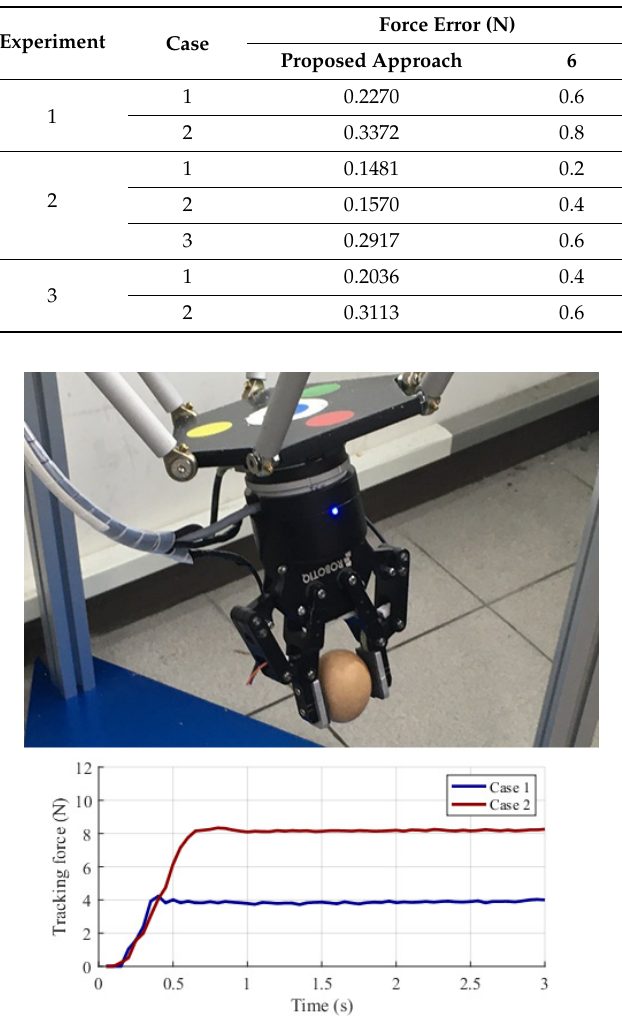
Figure 13. The tracking force of the comparative Experiment 1.